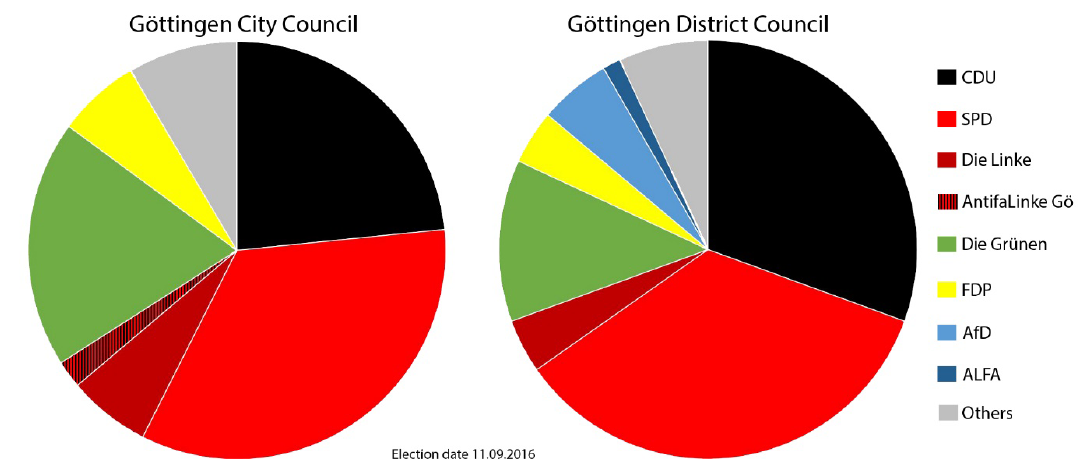
Figure 2. Comparison of political parties’ seat distribution in Göttingen City and district councils in 2016. Source: author, based on data from Stadt Göttingen (2018a) and Landkreis Göttingen